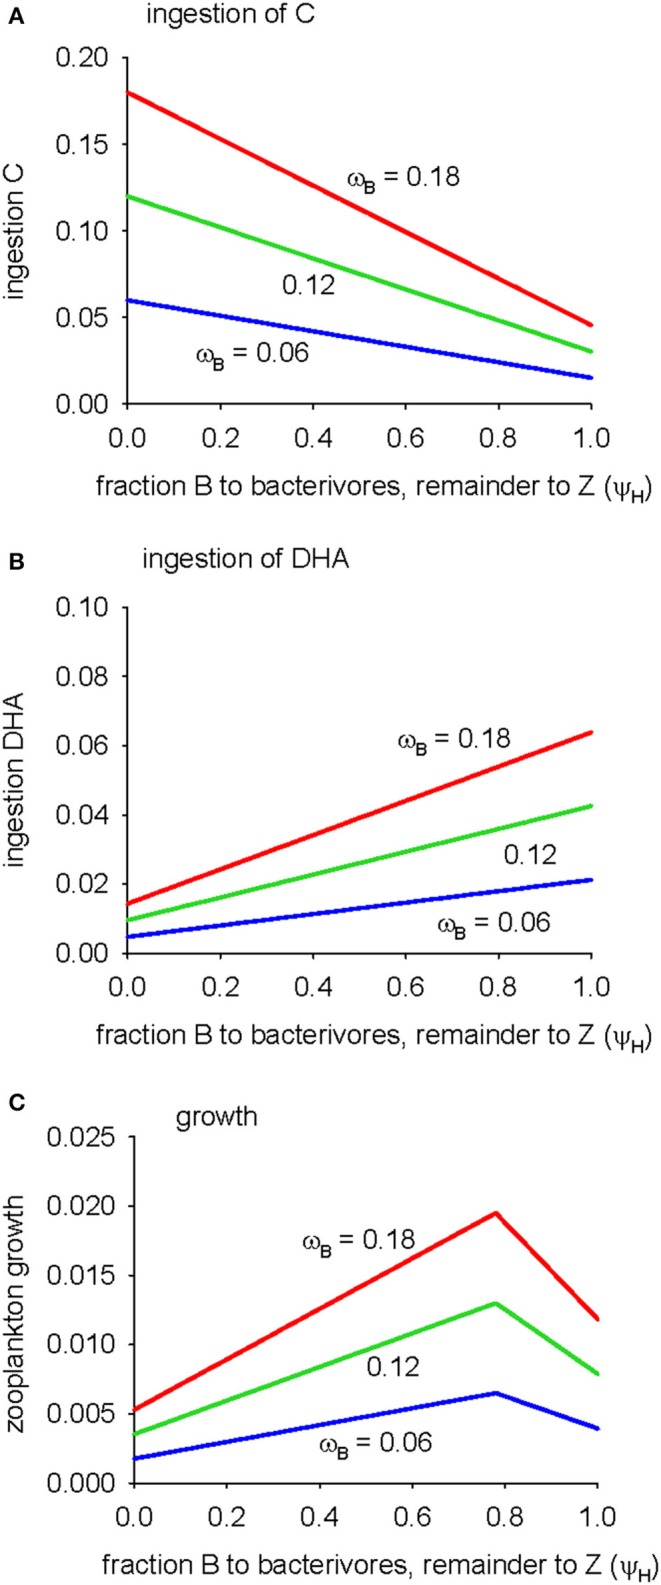
Sensitivity of zooplankton growth via the microbial pathway to parameter ψH (the fate of bacteria: fraction ψH to flagellates and fraction 1-ψH to zooplankton; standard value (Table 2) is ψH = 1), for B GGE (parameter ωB) = 0.06, 0.12, 0.18: (A) ingestion of C, (B) ingestion of DHA, (C) growth.